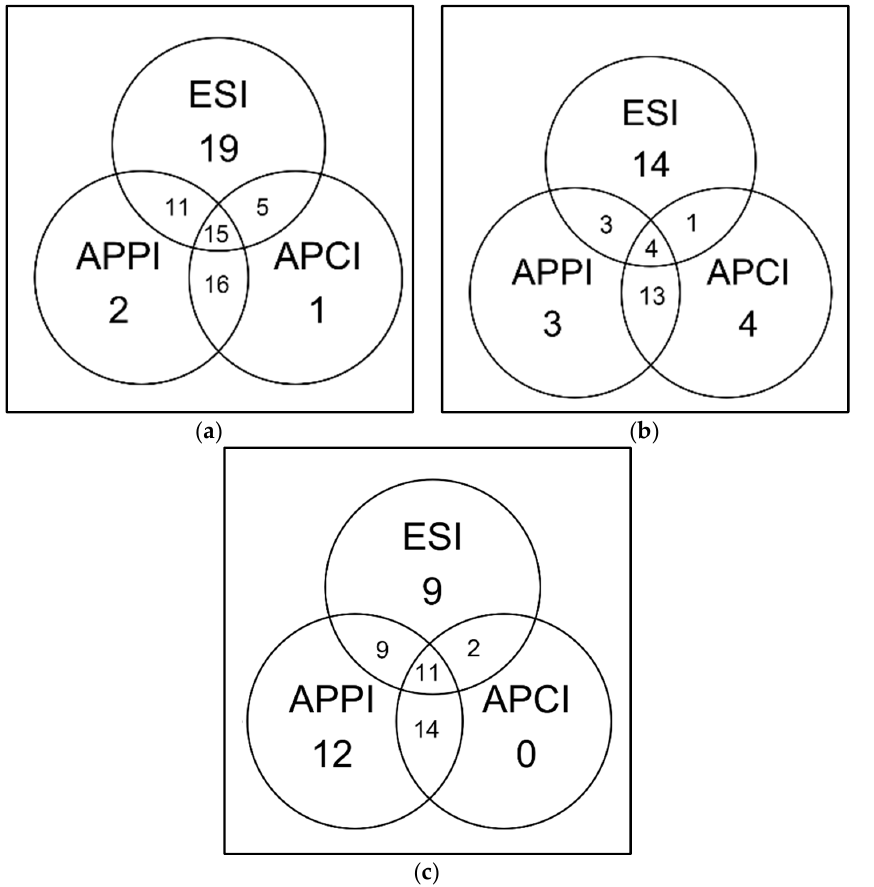
Figure 9. Venn’s diagram shows the number of peptides detected by ESI, APCI, APPI in bovine serum albumin (BSA) digests (10 µ L injected; c = 0.65 mmol · L − 1 ) obtained by ( a ) trypsin, ( b ) chymotrypsin, or ( c ) Glu-C cleavage of the protein. The peptides were separated at 60 ◦ C by a 25 min gradient elution; the mobile phase flow rate was 250 µ L · min − 1 . Data were evaluated using Amanda and Sequest